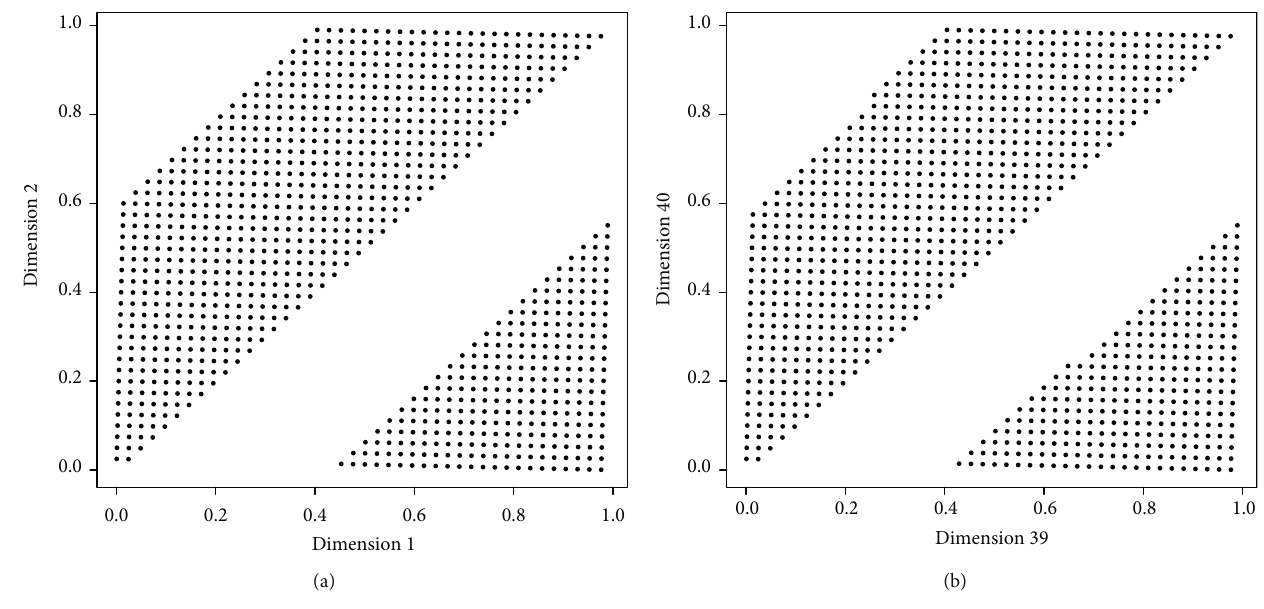
Figure 2: 1000 points from the original Faure